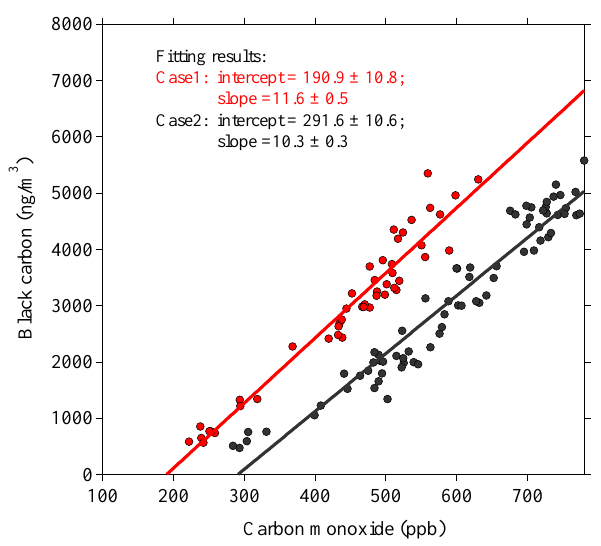
Fig. 5. Scatterplot and linear regression results of the BC-CO corre- lation during biomass burning episodes. Cases 1 (red) represents the episode on 22–23 October 2007 and Case 2 (black) for 6 January ∼ 8 2007.